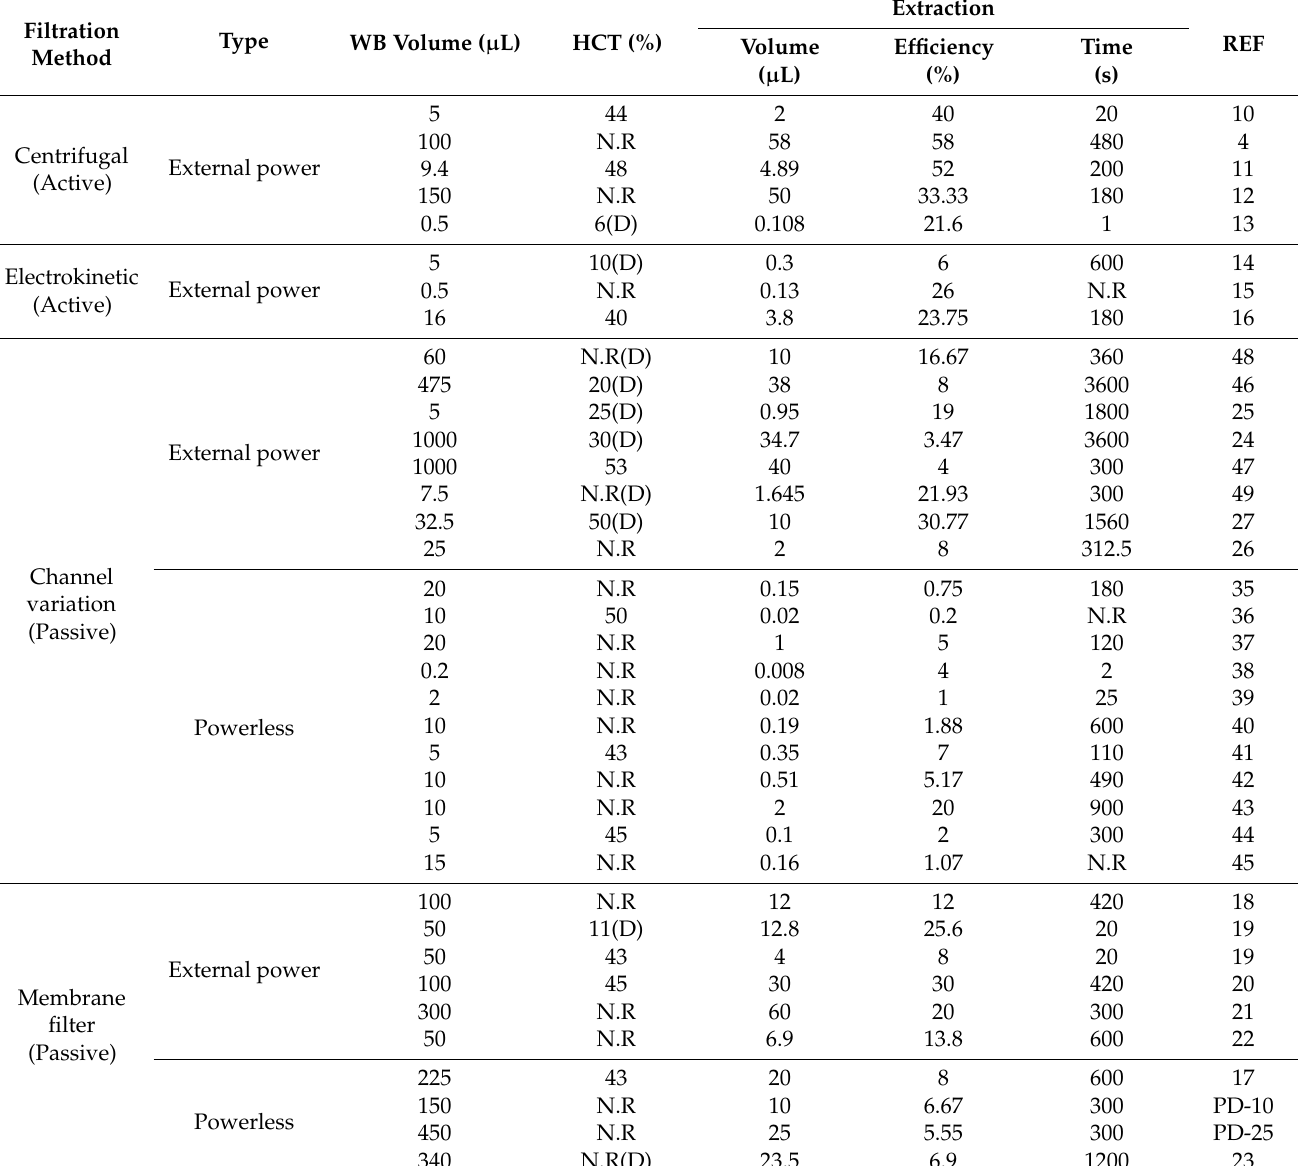
Table 1. Efficiency map of the channel variation methods. PD-10 and PD-25 indicate product number of PlasmaDrop Kits for Free Liquid Plasma from MDI Membrane Technologies INC. WB: whole blood, HCT: hematocrit, N.R: No reference, D: dilution. Plasma efficiency (%): volume percent between separated plasma and input